Question: In one sentence, what is this figure communicating?
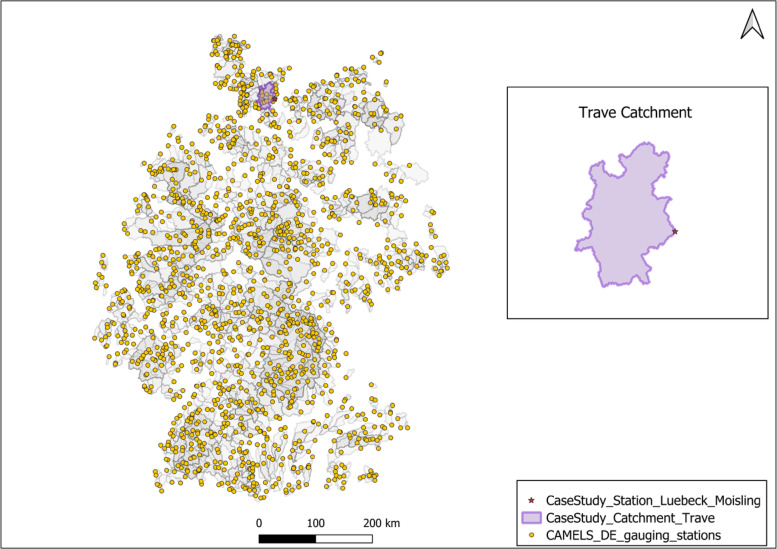
Answer: Spatial distribution of CAMELS-DE gauging stations across Germany, along with the location of the selected case study. The Trave catchment and the Lübeck-Moisling gauging station are highlighted. The inset map provides a detailed view of the case study basin.